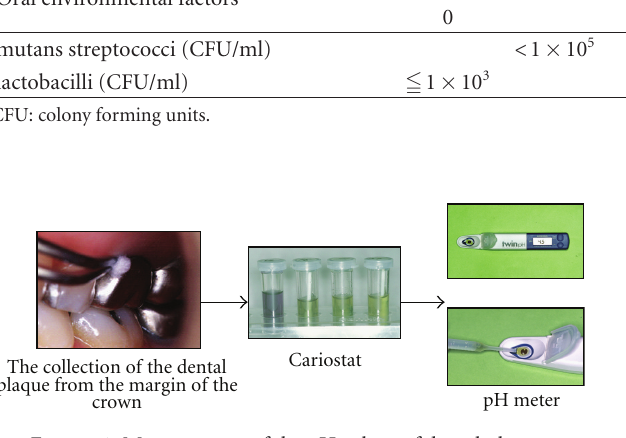
Figure 1: Measurement of the pH values of dental